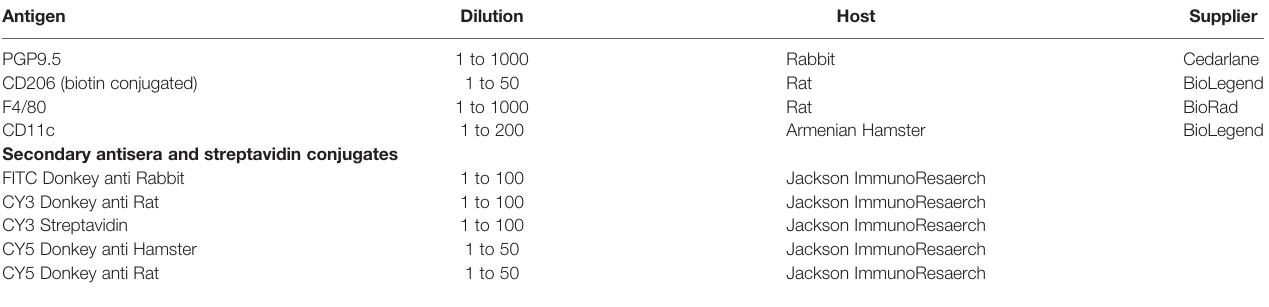
TABLE 1 | Antibodies and antisera used to label vaginal sections.